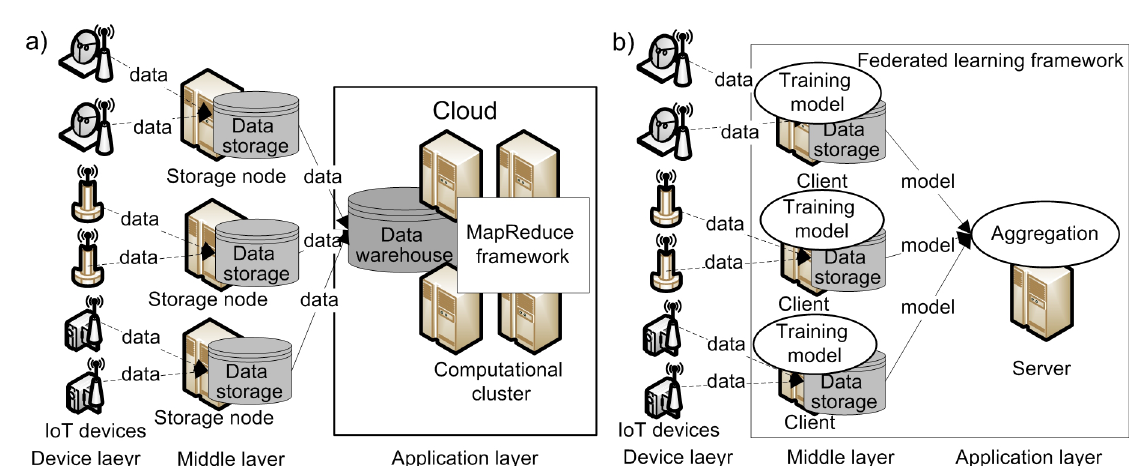
Figure 1. Internet of Things (IoT) system with: ( a ) distributed learning; ( b ) federated